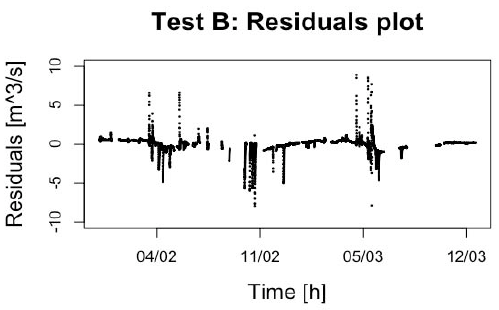
Fig. 5. Test B: plot of the residuals for the validation period. Large values are usually due to time shifts between the measured and sim- ulated discharge.